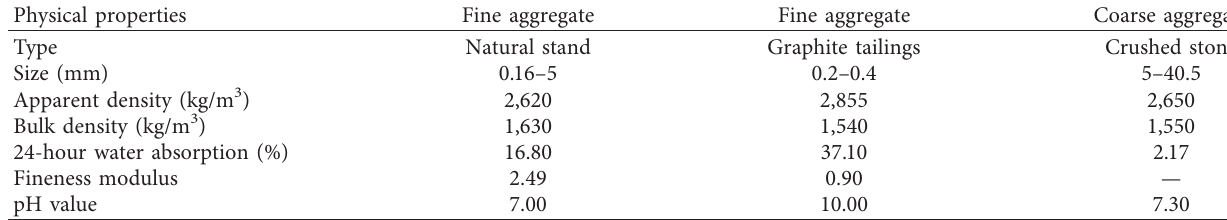
Table 4: Properties of sand, graphite tailings, and stone.